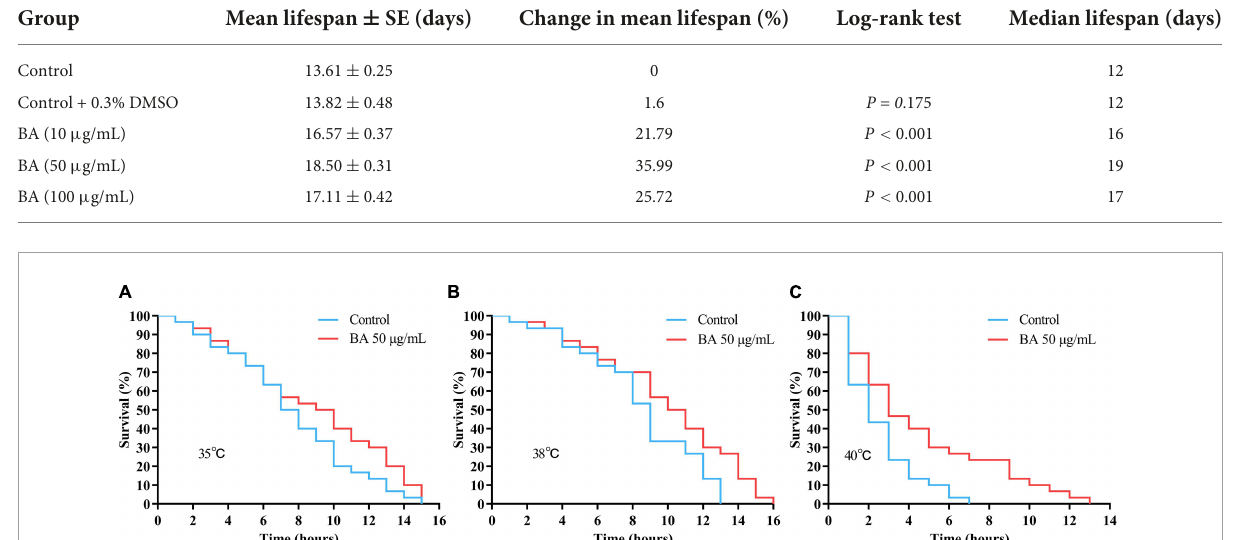
TABLE 2 Effects of betulinic acid (BA) on lifespan of Caenorhabditis elegans. Group